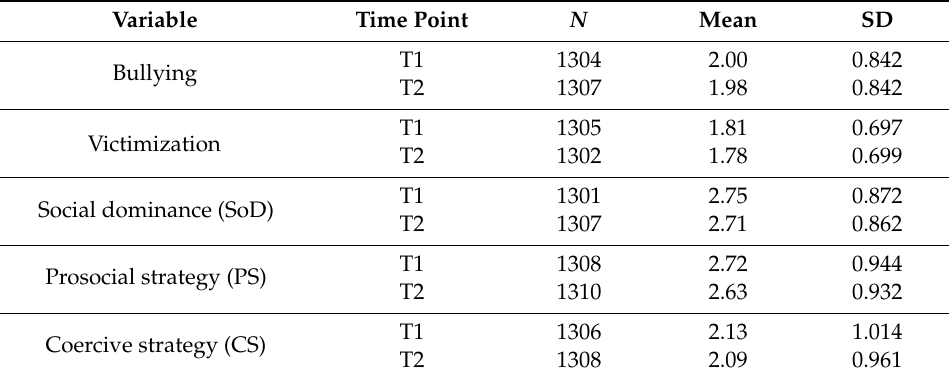
Table 1. Descriptive statistics for bullying roles, SoD, PS, and